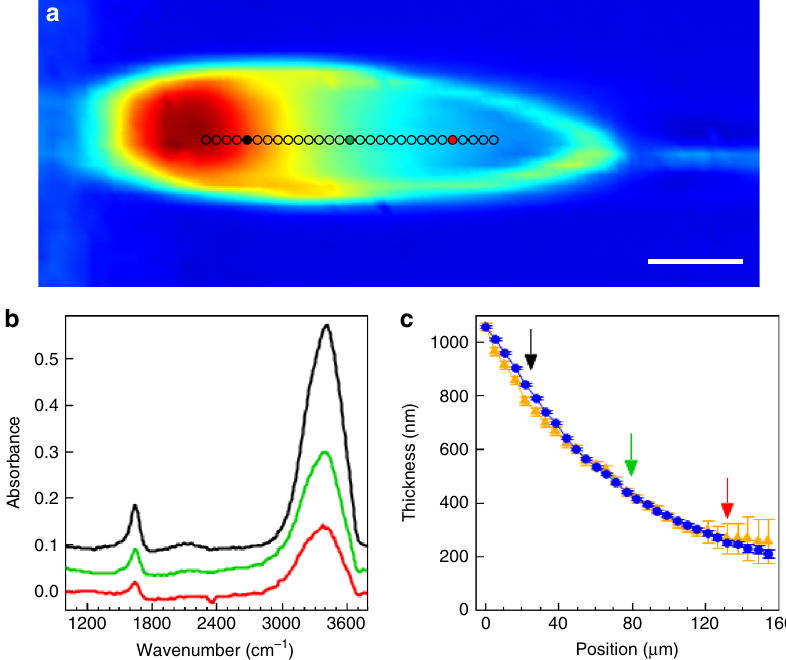
Fig. 8 Infrared spectromicroscopy of liquid water sheets. a A false-color image of the integrated IR transmission (3100 – 3650 cm − 1 ) through a water sheet with 250 µ L min − 1 fl ow rate, under similar conditions as Fig. 4. The scale bar is 50 µ m. b The infrared spectra of the water sheet at three points along the sheet, as indicated by the black, green, and red colored circles in a . The black and green spectra are offset for clarity. c The calculated sheet thickness along the central region of the water sheet, as indicated by the markers in a , using values of the O – H stretch mode at 3404 cm − 1 (blue circles) and the H 2 O bending mode at 1643.5 cm − 1 (gold triangles). The black, green, and red arrows indicate the positions of the respective colored markers in a , as well as the colored spectra in b . The error bars in c represent an estimate of the uncertainty of the absorption measurement based on the signal-to-noise ratio of the peaks of interest. In this case, the error bars are calculated by measuring the baseline noise (peak-to-peak) on either side of the peak of interest and scaling the error for the calculated thickness by standard error propagation